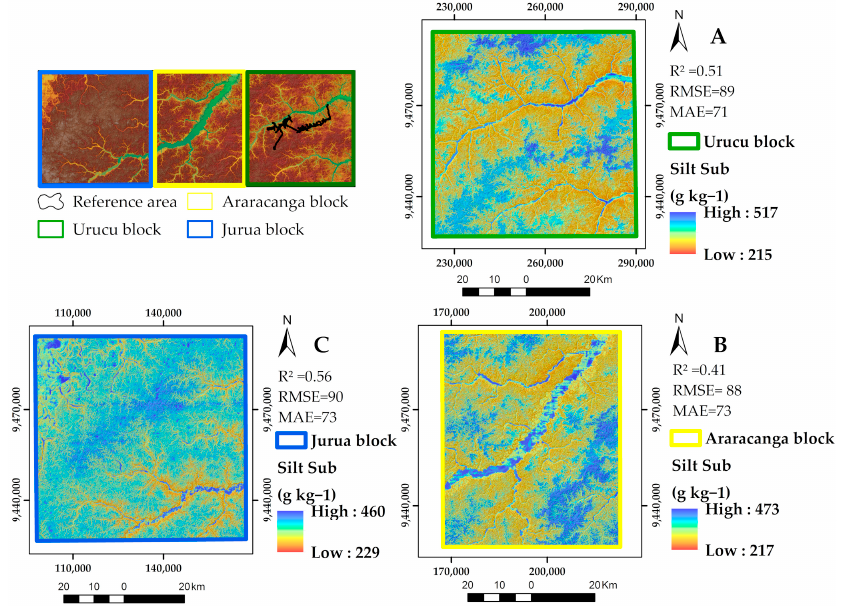
Figure 12. Map of the silt content at the subsurface layer. (Map generated using the Reference Area sampling design, Random Forest, and Previous Covariate Selection), ( A ) Urucu block, ( B ) Araracanga block, ( C ) Jurua Predicted clay contents ranged from 47 to 303 g kg − 1 at the surface (Figure 13), and increased at the subsurface, ranging from 154 to 458 g kg − 1 at the subsurface (Figure 14). The increase of clay with depth is consistent with the occurrence of Ultisols, which present